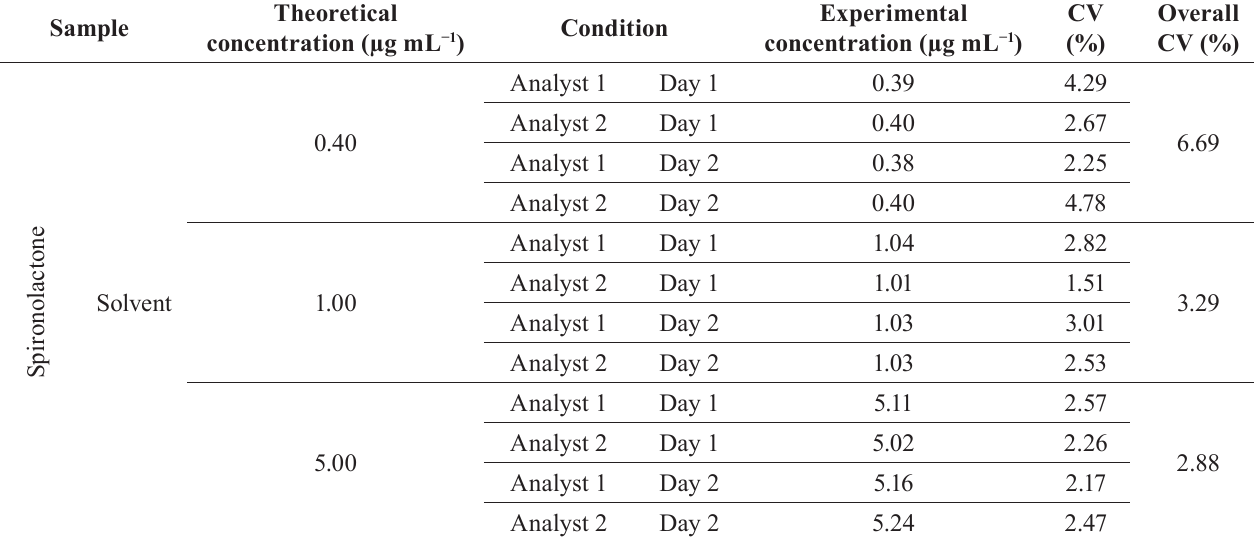
TABLE III – Results of the intra- and interassay precision of the analytical method for quantifying spironolactone and canrenone in methanol and